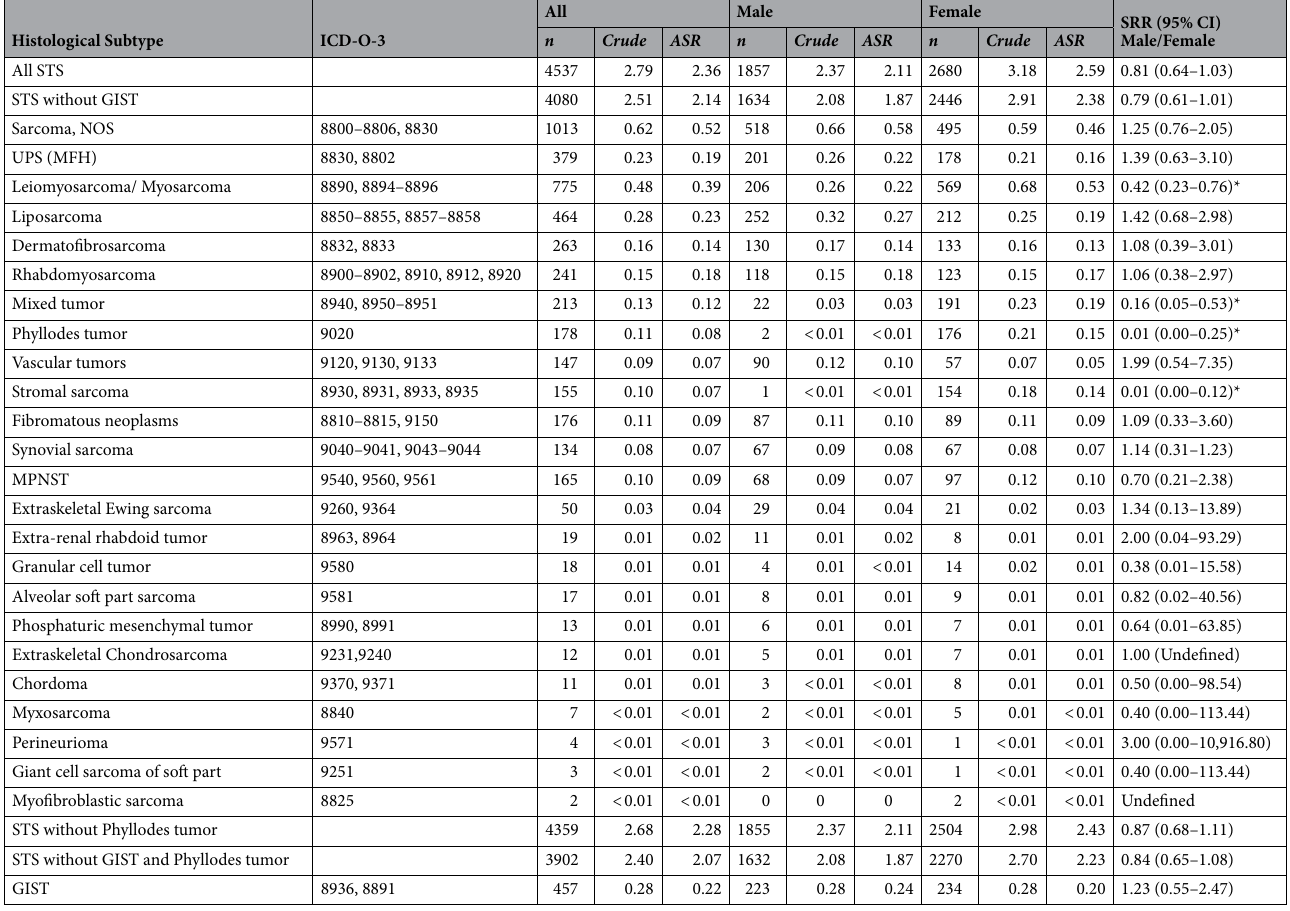
Table 1. Crude and age-standardized incidence of soft tissue sarcoma and gastrointestinal stromal tumor by histological subtype and sex. Case count, crude and age-standardized incidence rates per 100,000 person-years, and SRR are reported. The ASR was adjusted to the Segi world standard population. * indicates that the rates are significantly different at the 5% level ( p < 0.05